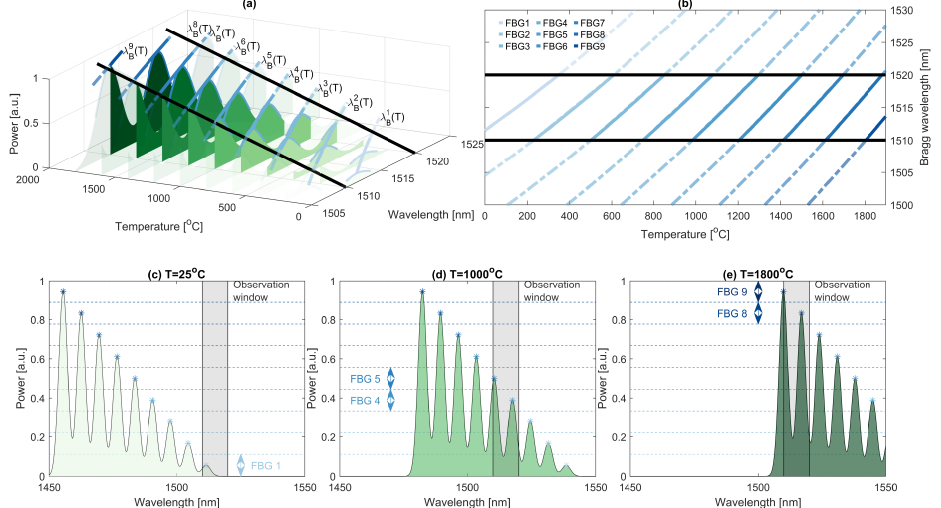
Figure 14. ( a ) Simulation of SFBGs spectra for different temperatures acting on sensors. The spectrum of each grating shifts with respect to the Equation (2). The black lines indicate spectral measurement range of the interrogator. ( b ) Bragg wavelength for each SFBG sensor in the function of a temperature. Spectrum received from all sensors for 25, 1000, and 1800 degrees Celsius is presented in ( c ), ( d ), and ( e ), respectively. The dashed lines in ( c – e ) represent reflectance confidence